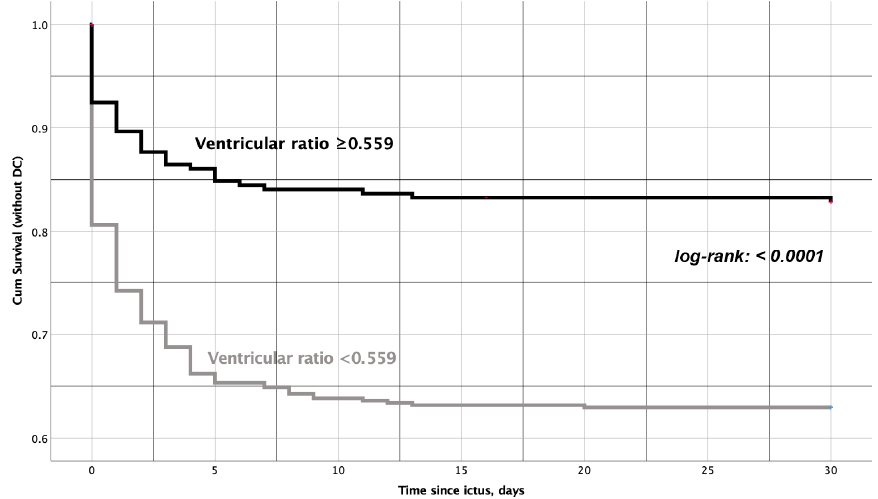
Figure 2. Kaplan–Meier survival plot showing the diagnostic value of the ventricular ratio (with cut-off of 0.559) for predicting the need for DC and its timing. The probability to survive SAH without DC was significantly higher in patients with larger ventricles. SAH patients with smaller ventricles underwent DC more frequently. Table 3. Components and weights of parameters in the prediction model for decompressive craniectomy.